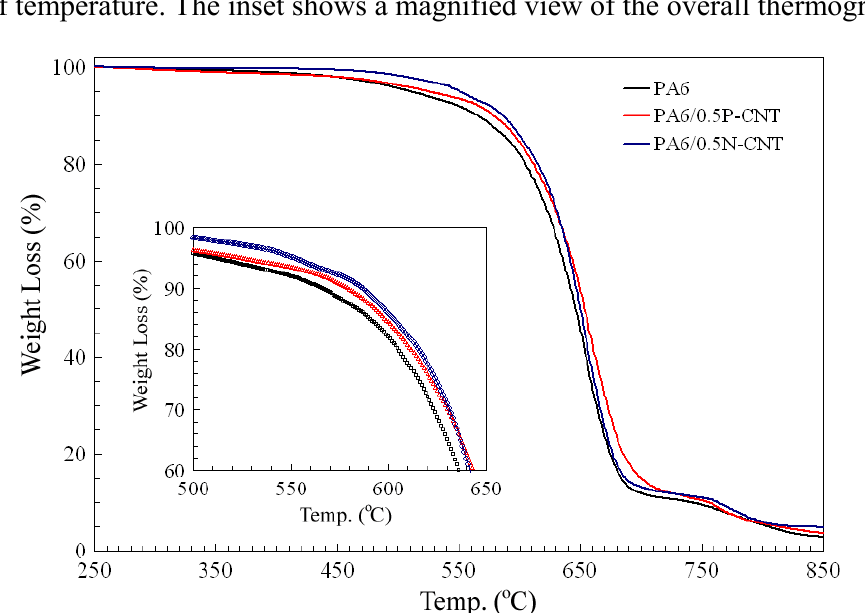
Figure 5. Thermographs of neat and composite PA6 samples indicating weight loss as a function of temperature. The inset shows a magnified view of the overall